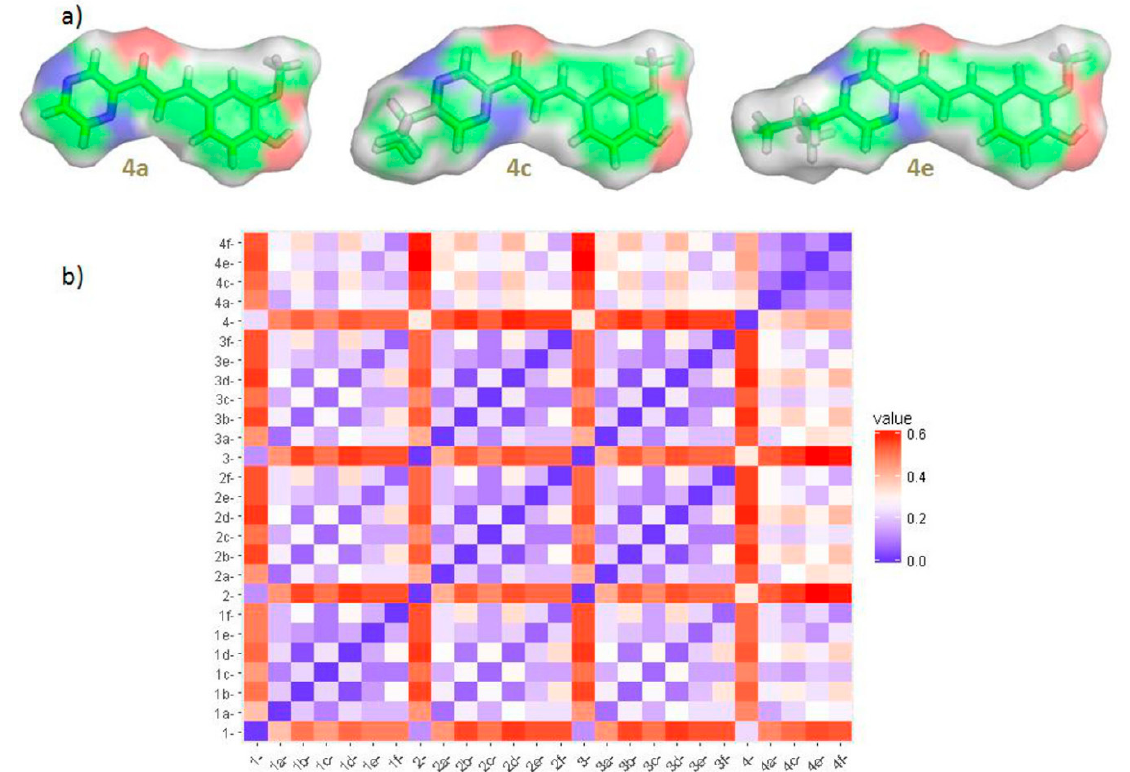
Figure 3. ( a ) Equilibrium ground-state structures (M052X/6-311++G**) with a Connolly surface (white parts correspond to nonpolar surface area) of the radical scavengers 4a, 4c and 4e; ( b ) Clustering of 26 compounds (Table 1) according to their structural similarity (more blue/red—more similar/dissimilar compounds).